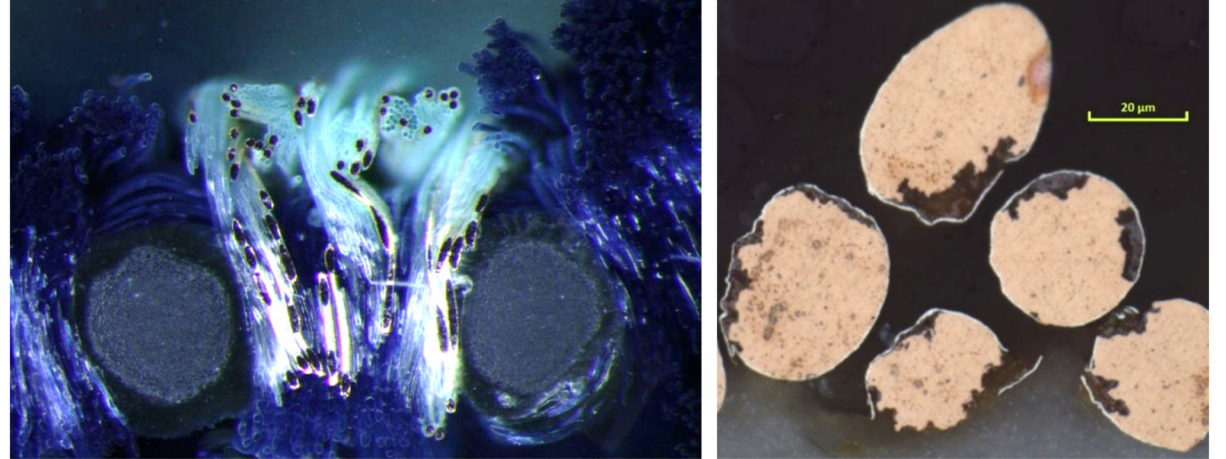
Figure 11. Microscopic observation of metallographic cross-sections of ribbon traces after artificial sweat